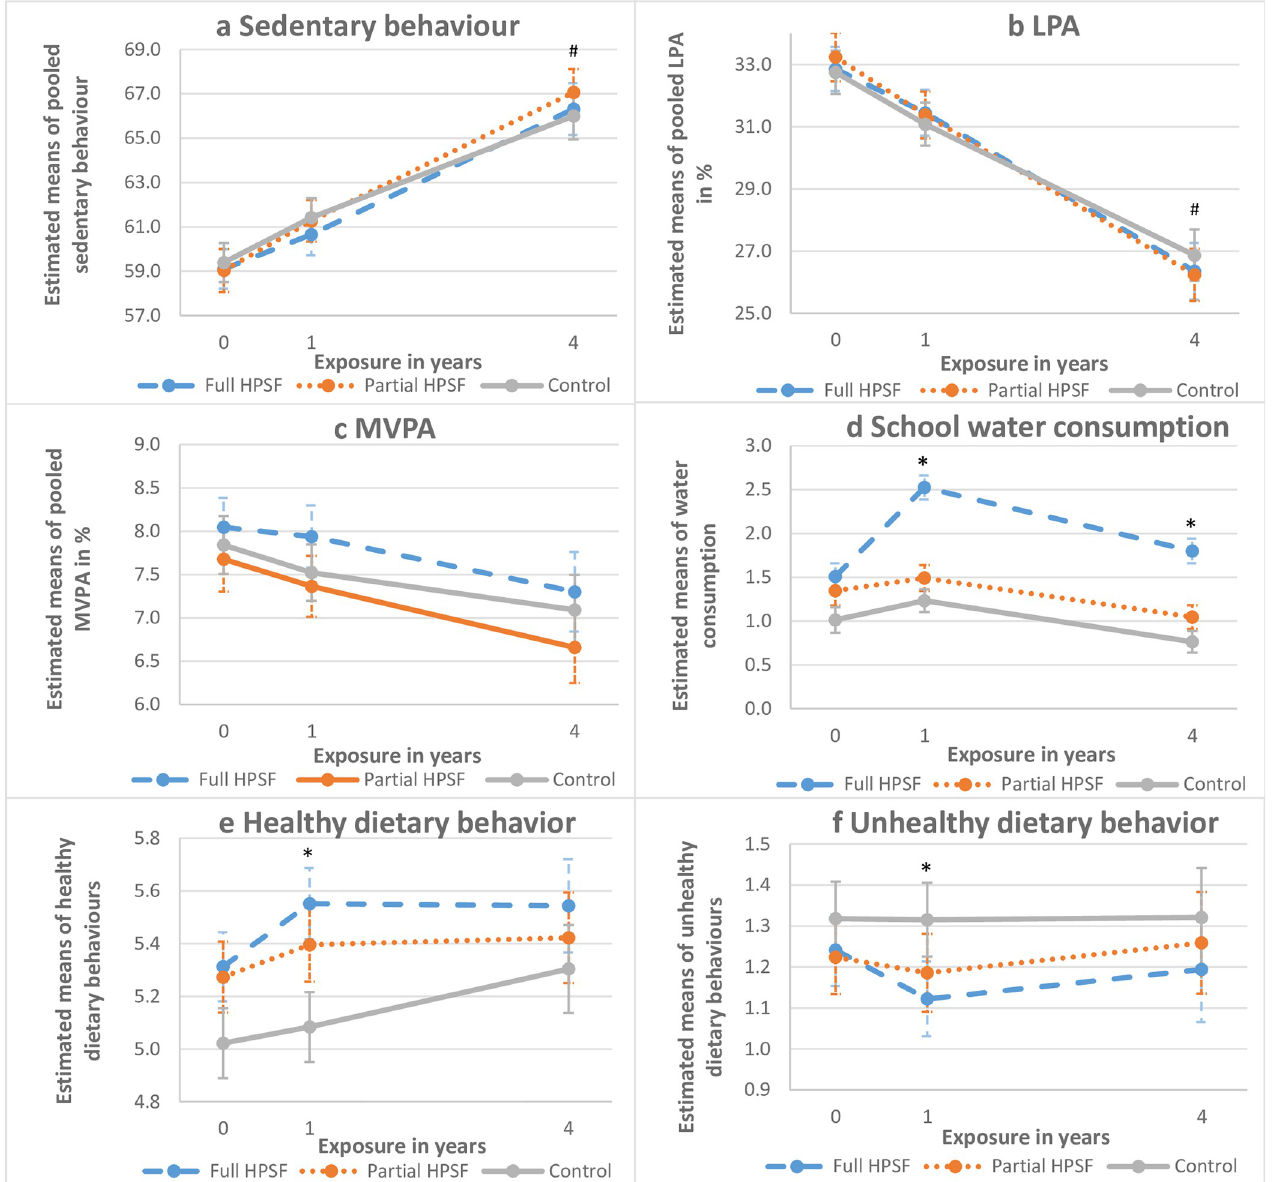
Fig 3. Estimated means of children’s dietary and PA behaviours at baseline, one and four years of exposure; a) Sedentary behaviour; b) LPA; c) MVPA; d) school water consumption; e) Healthy dietary behaviour; f) Unhealthy dietary behaviour. Abbreviations: HPSF, Healthy Primary School of the Future; LPA, light physical activity; MVPA, moderate to vigorous physical activity. � = significant difference between Full HPSF and control. # = significant difference between Partial HPSF and control. of healthy lunch components increased compared to control schools (vegetable (OR = 2 � 58), fruit (OR = 1 � 74), dairy (OR = 3 � 04), intake of a minimum of two healthy food groups (OR = 3 � 04)). Butter consumption (OR = 0 � 25) and grain intake during lunch (OR = 0 � 54) decreased significantly. At E4, most of the short-term intervention effects in full HPSFs were no longer significant (healthy behaviours ES = -0 � 05; unhealthy behaviours ES = -0 � 07). The intervention effects on school water consumption (ES = 0 � 46) and dairy intake remained